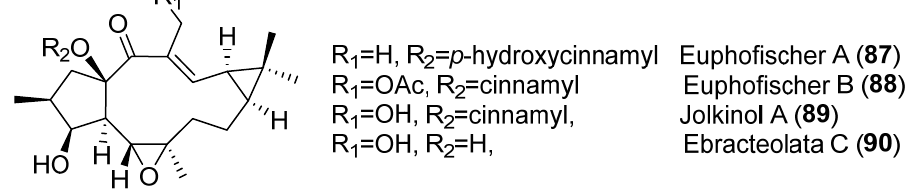
Figure 12. Cytotoxic lathyranes diterpenoids ( 87 – 90 ) from the roots of E. fischeriana. In a previous study with diterpenes from E. fischeriana , jolkinol A ( 89 ) (Figure 12), the inhibitory activity on the formation of mammospheres in human breast cancer MCF-7 cells was observed [42]. Furthermore, jolkinol B ( 83 ) (Figure 9) was isolated from the roots of E. ebracteolata Hayata, and its cytotoxic activity tested against five cancer cell lines: HL-60 (human promyelocytic leukemia cell line), SMMC-7721 (human hepatocellular carcinoma cell line), A-549 (human lung cancer cell line), MCF-7 (human breast cancer cell line) and SW480 (colorectal cancer cell line), where it exhibited moderate cytotoxic effects [43]. Lathyrane diterpenoids isolated from E. lathyris , named Euphorbia factors (EF), have been subjected to several anticancer studies. Thus, among the cytotoxicity against cancer cell lines A549, MDA-MB231, KB and MCF-7, and the MDR cancer cell line KB-VIN of six compounds with different structural features, EFL 1–3 ( 76 , 77 and 43 ) (Figures 6 and 8), EFL 8–9 ( 91, 80 ) (Figures 8 and 13) and the tetraol derivarive of 91 (compound 92 ) (Figure 13), EFL 9 ( 80 ) exhibited the strongest activity against all tested cell lines and EFL 2 ( 77 ) was found to be selective against KB-VIN, while 76 and 92 were inactive. The SAR studies revealed that the substitutions at C-3, C-5, C-7 and C-15 are critical for cytotoxicity, as well as cell type-selectivity [44]. A combination of acetate groups at C-5 and C-15 and benzoate groups at C-3 and C-7 seems to be required for selective cytotoxicity against KB-VIN (Figure